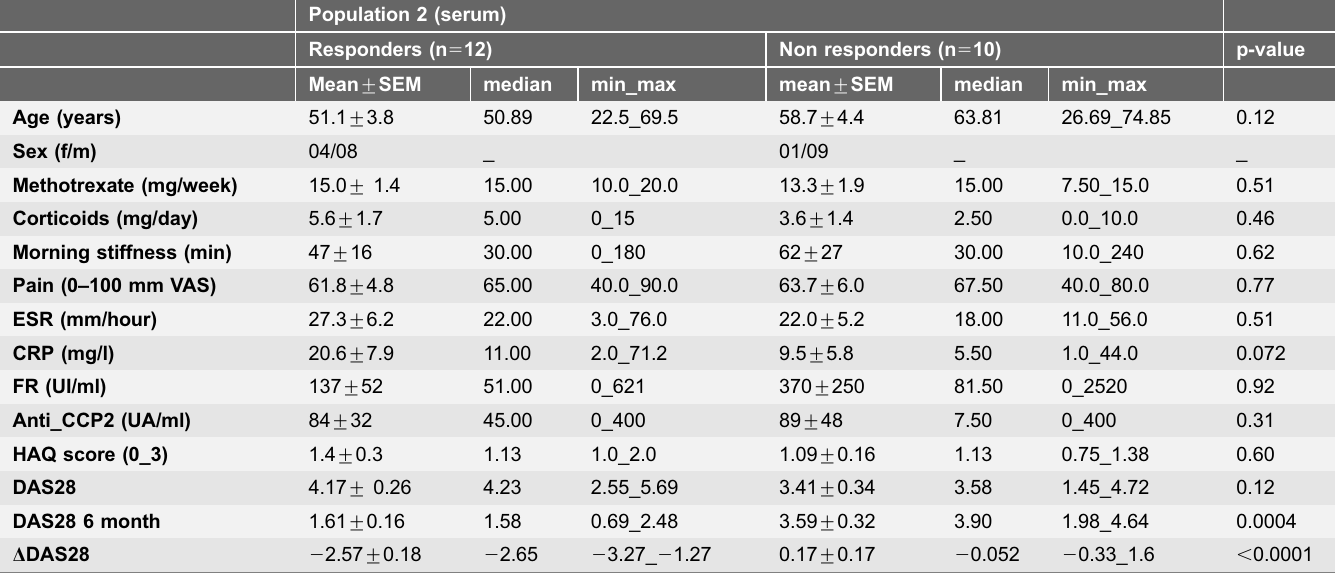
Table 1. Demographic, clinical and biological data of RA patients at